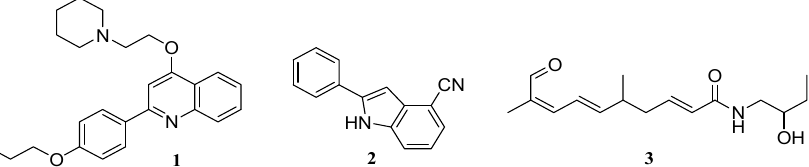
Figure 1. Chemical variety of compounds able to restore antibiotic efficiency in staphylococci ( 1–3 ).